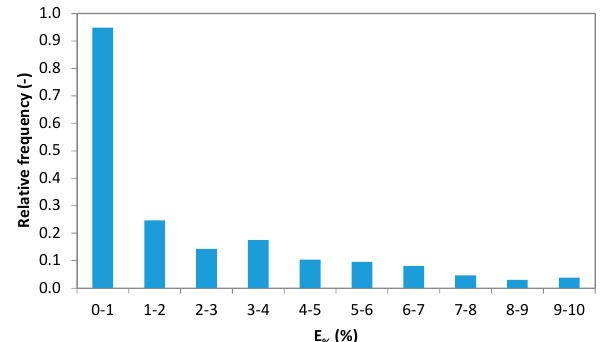
Figure 5. Similar to Figure 4c but with classes’ amplitude equal to 1%. Atmosphere 2018 , 9 , x FOR PEER REVIEW